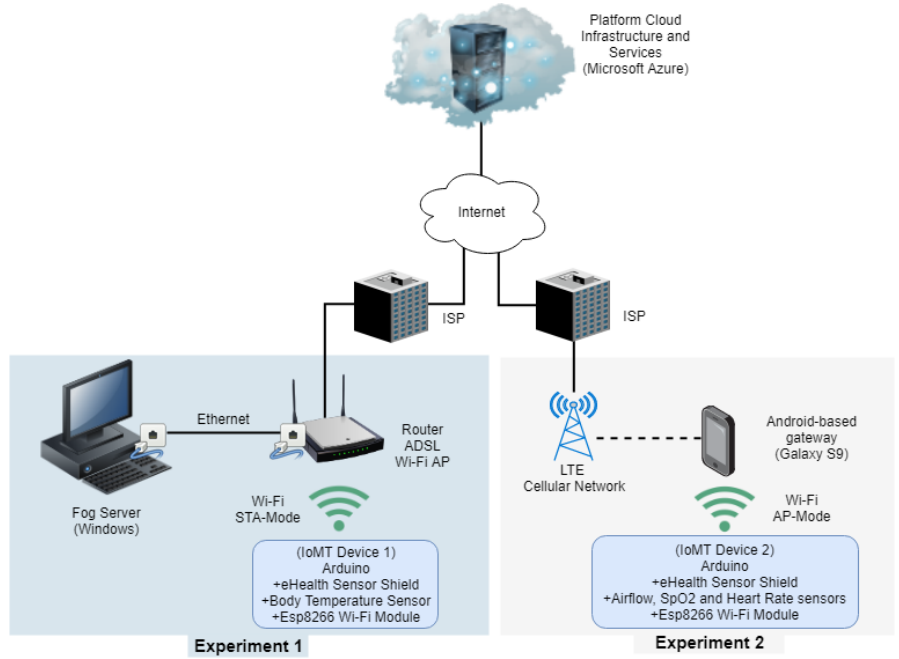
Figure 13. Network topology considered for